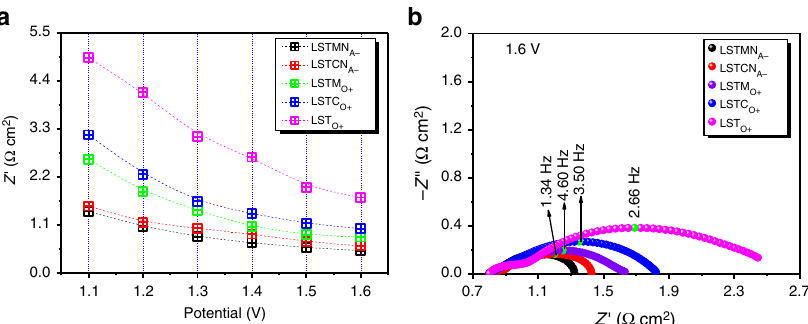
Figure 6 | AC impedance spectroscopy with different cathodes. ( a ) The comparison of R p for the high-temperature CO 2 electrolysis with different electrode; ( b ) in situ AC impedance at 1.6V.